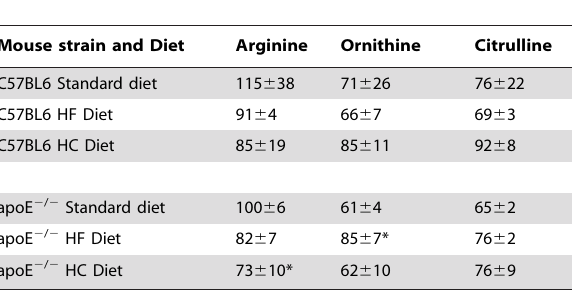
Table 1. Effect of diet on plasma amino acid levels ( m M) in C57BL/6J and apoE 2 / 2